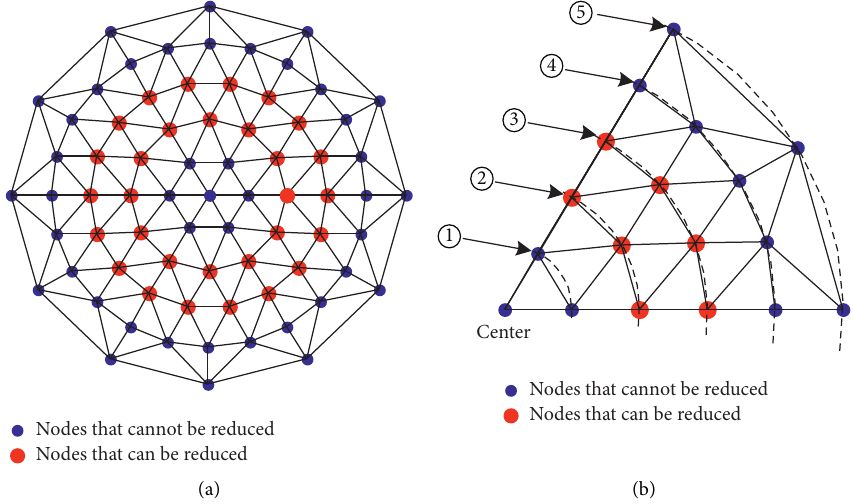
Figure 4: Initial geometric configuration of a mesh reflector. (a) Classifications of the reflector nodes. (b) One-sixth model of the reflector. Note . ① is a node on the first ring, ② is a node on the second ring, ③ is a node on the third ring, and ④ and ⑤ are the nodes on the secondary outer and outermost rings, respectively.